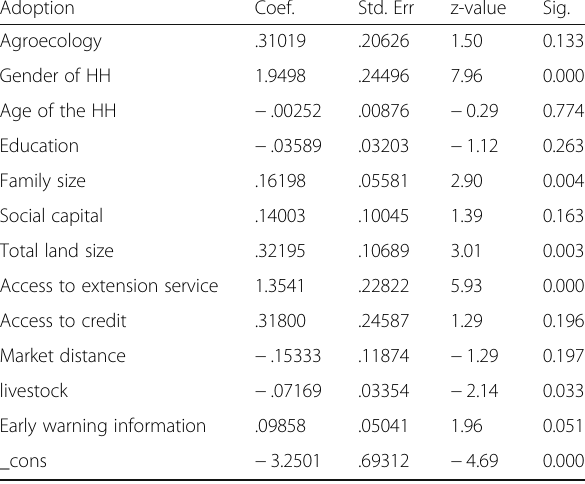
Table 3 Estimation of propensity score through probit regression